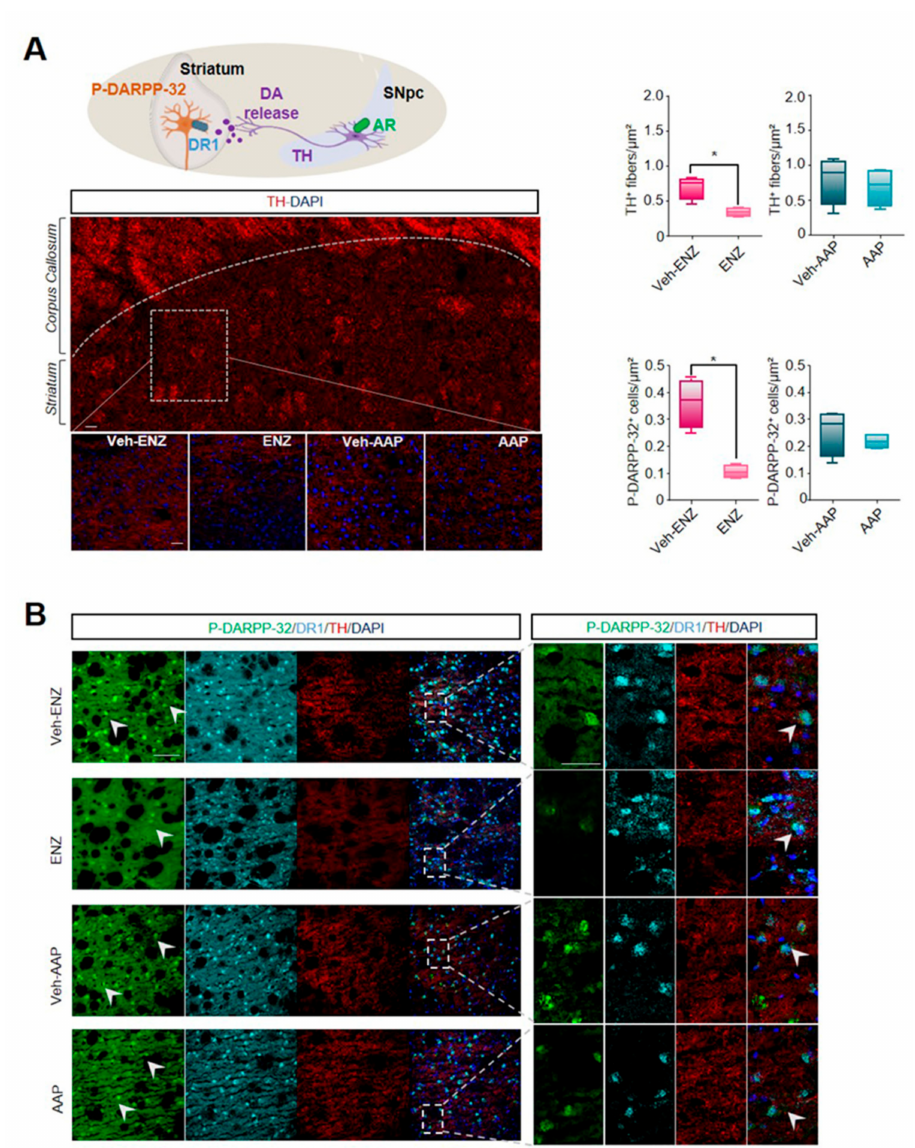
Figure 4. ENZ modulates midbrain dopaminergic release to striatum. Note. ( A ) Schematic represen- tation of SNpC dopaminergic projections to striatum and consequent striatal neuronal activation. Immunofluorescence of TH + -DA striatal projections of ENZ-, AAP- and vehicle-treated mice (seen on magnification of squared areas). Scale bar: 100 µ m. On the right, Whisker boxes represent TH + fibers intensity and the number of P-DARPP-32 + cells in the striatum of ENZ- and AAP-treated mice compared with respective vehicles. Statistical quantifications were performed using Mann– Whitney test. Data are represented as box and whiskers of mean ± SEM ( n = 4 mice), * p < 0.05. Scale bar: 100 µ m. ( B ) Representative images of Dopamine cAMP-Regulated Neuronal Phosphoprotein P-DARPP-32 + —(green), DA receptor 1 + —(DR1, cyan), TH + —(red) positive fibers and DAPI (blue) immunoreactivities in striatum of ENZ-, AAP- and Vehicle-treated mice. Scale bar: 25 µ m and 100 µ m. AAP, abiraterone acetate-prednisone; DA, dopamine; DAPI, 4 (cid:48) ,6-diamidino-2-phenylindol; ENZ, enzalutamide; P-DARPP-32, Phosphorylated form of Dopamine cAMP-Regulated Neuronal Phos- phoprotein; DR1, DA receptor 1; SNpc, substantia nigra pars compacta; TH, Tyrosine hydroxylase; vHp, ventral